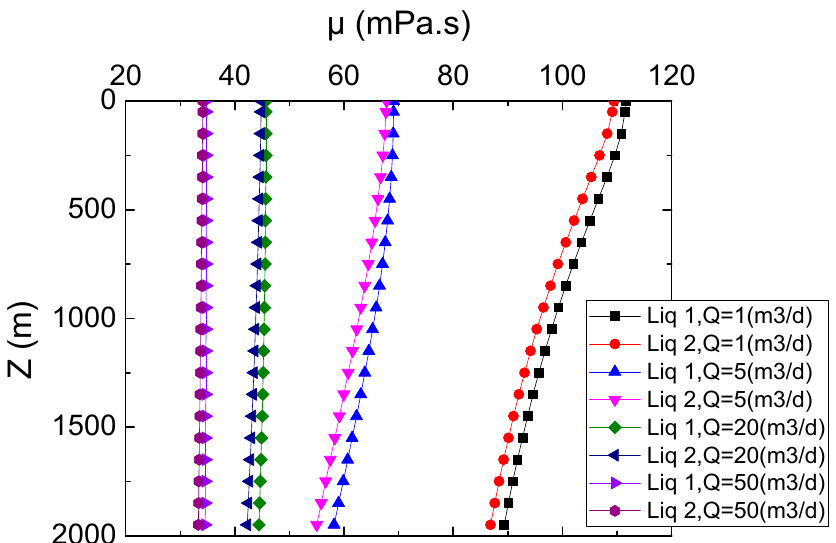
Figure 8. The influence of injecting rates on viscosity. As injecting rates increase, the viscosity loss greatly decreases. Normally, as the injecting rates are larger than 20 m 3 /d , the viscosity loss can be